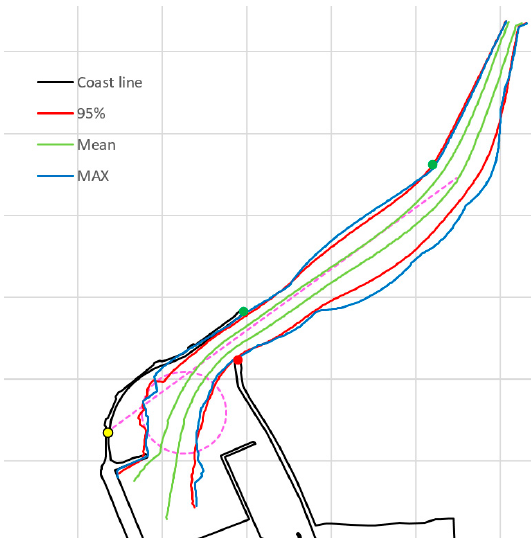
Figure 12. Manoeuvring areas of a general cargo ship of L = 133 m on approach to modernized Ustka Port by “Soft-Bank” with limited (preliminary) navigational marking.